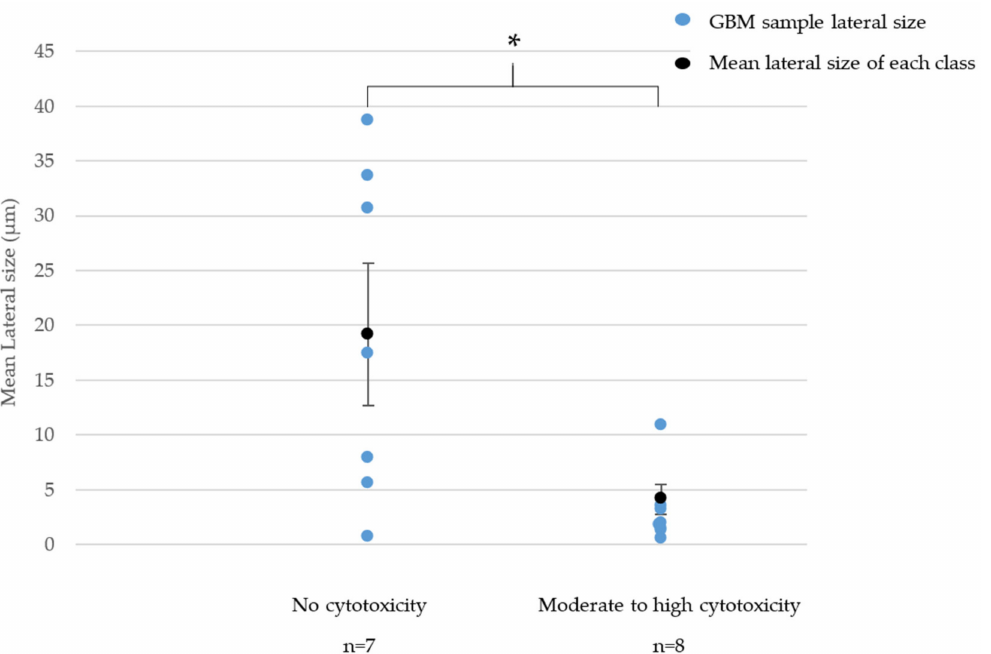
Figure 2. Relationship between cytotoxicity and lateral size for GNPs. * = p < 0.05 (Student